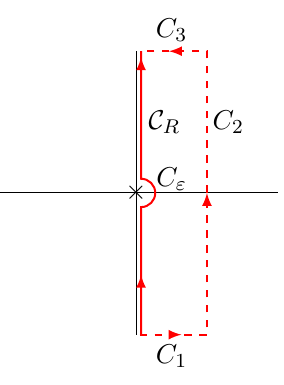
with a; b > 0 and c > 1. C " denotes the z c